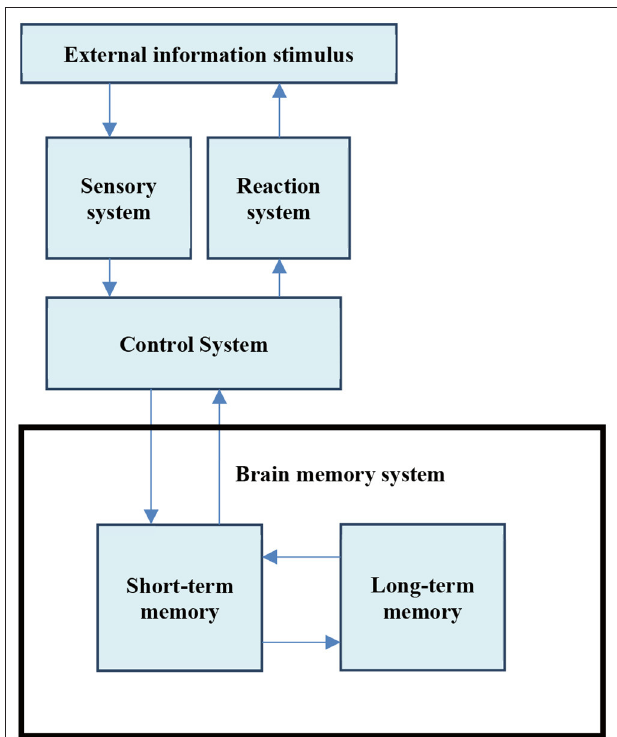
FIGURE 1 | Information processing model.